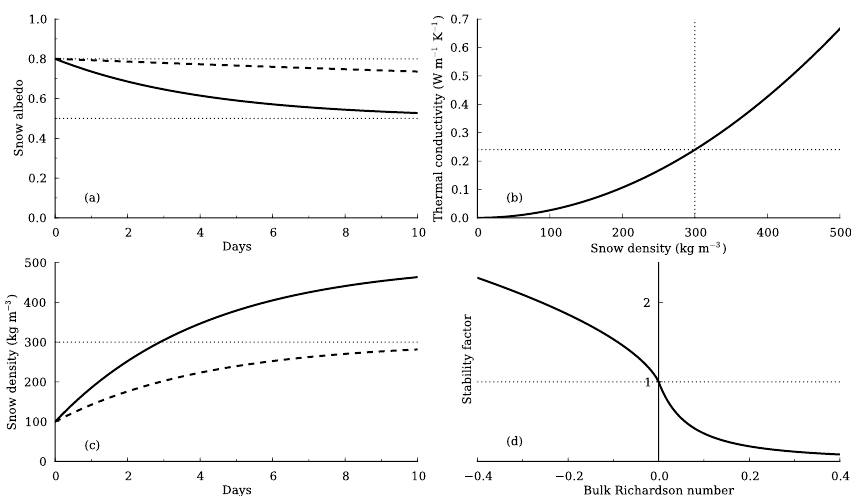
Figure 3. (a) Albedo decay as functions of time for cold snow (dashed line) and melting snow (solid line). (b) Thermal conductivity of snow as a function of density. (c) Snow density as functions of time for cold snow (dashed line) and melting snow (solid line). (d) Atmospheric stability factor as a function of bulk Richardson number. Dotted lines show constant values used when parametrizations are switched